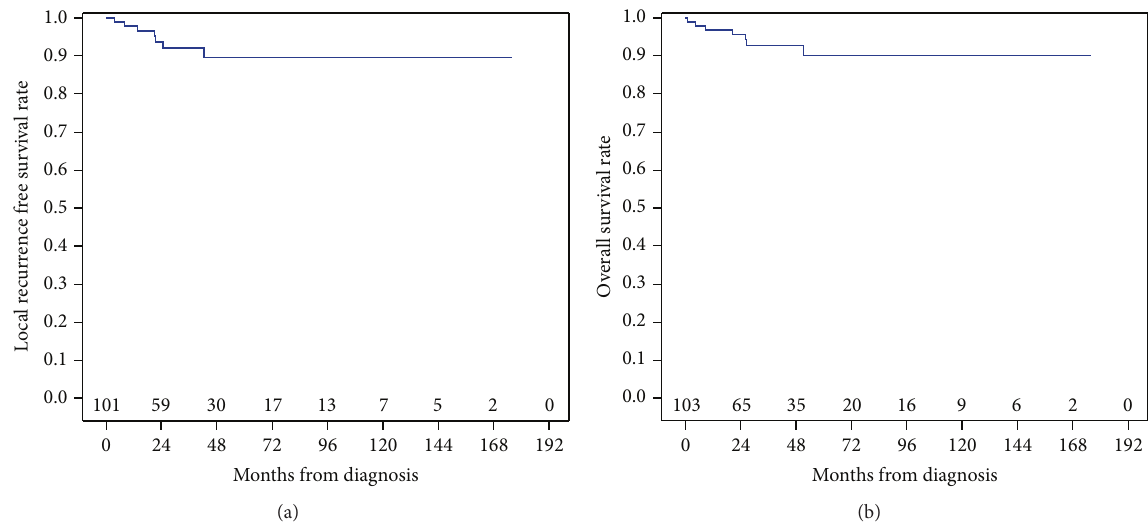
Figure 1: For all patients with S-STS, the local recurrence free survival (LRFS) rate was 93.2% (a), with median overall survival (OS) rate of 93.2%